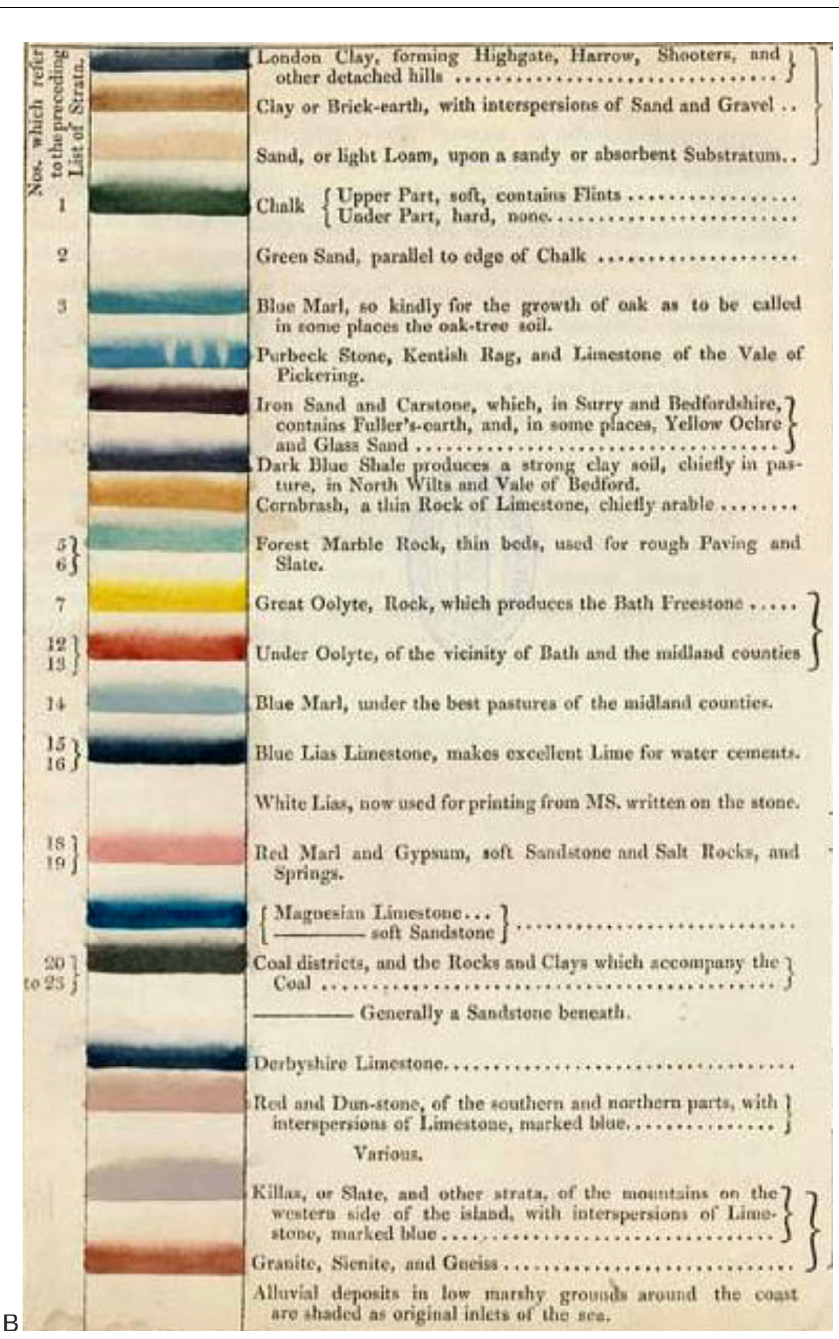
Fig. 7. Comparison of two colour explanations used by W. Smith: A − on A Delineation of the Strata of England... (1815), and B − on the sheet containing his writing titled A memoire to the map … (1815) (from the collection of The Geological Society of